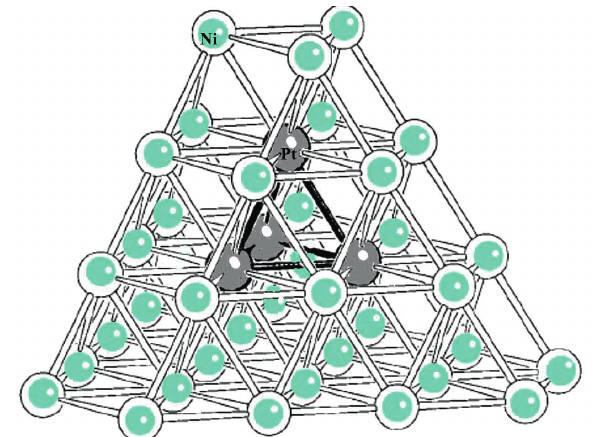
Ni (CO) ] 6- anion [35]. 4 36 45